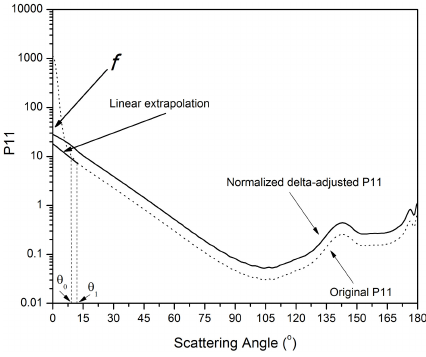
Fig. 2. Illustration of delta adjustment on phase